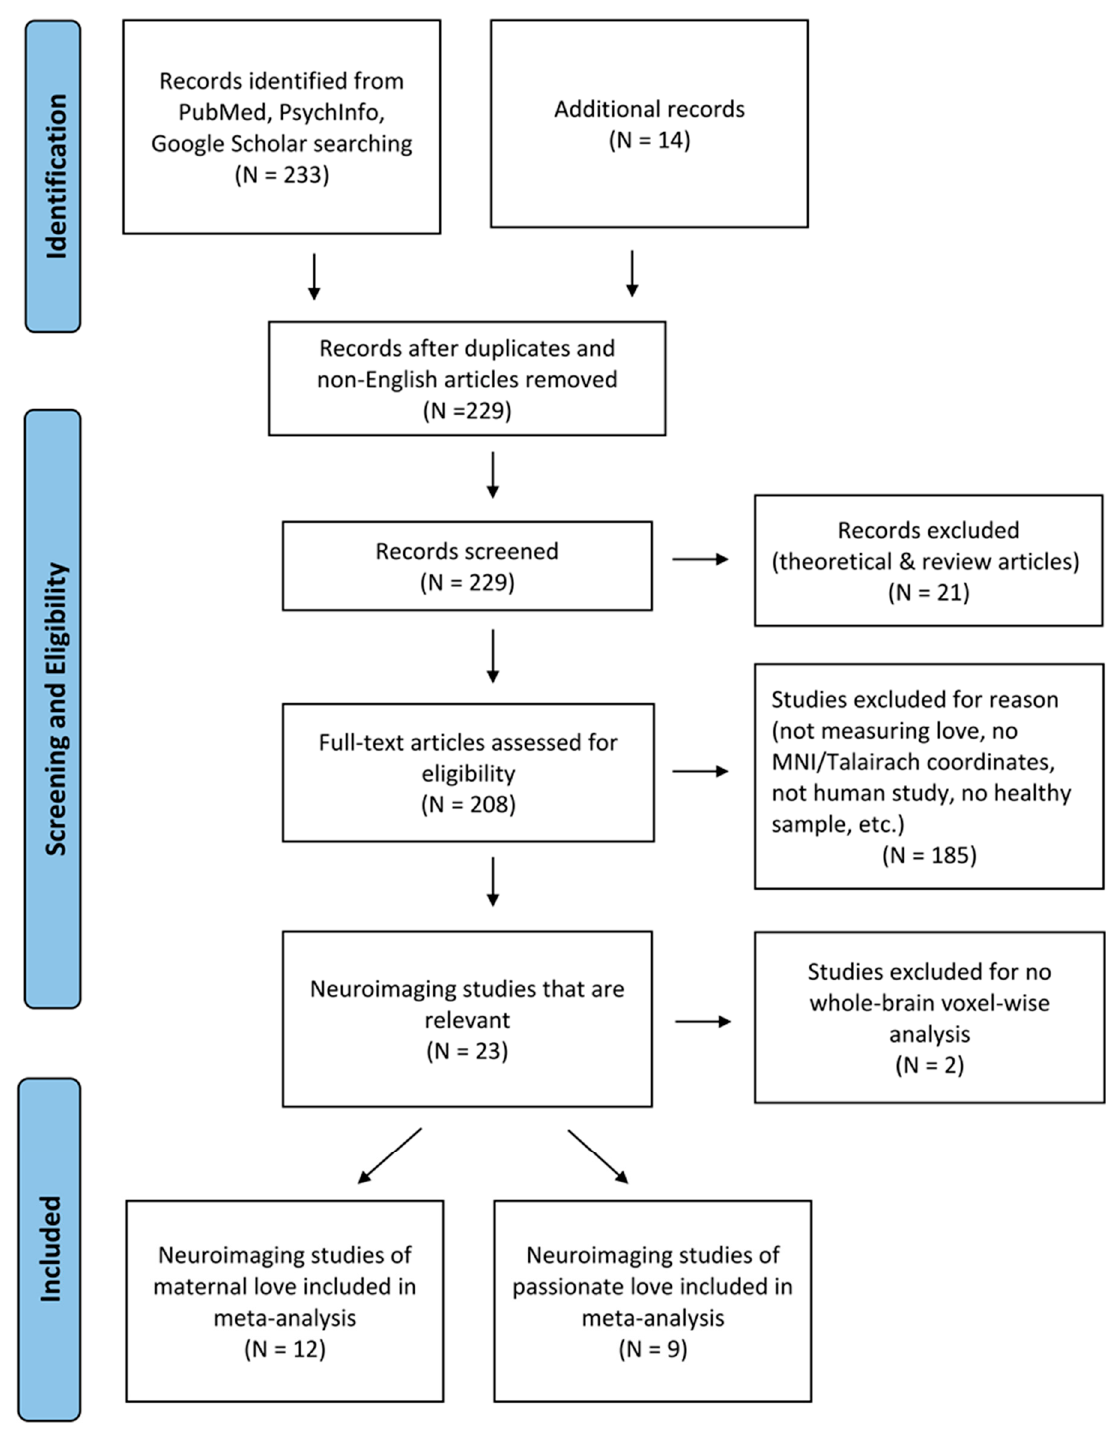
Figure 1. The PRISMA flowchart of literature search and study selection for meta-analysis of human love.